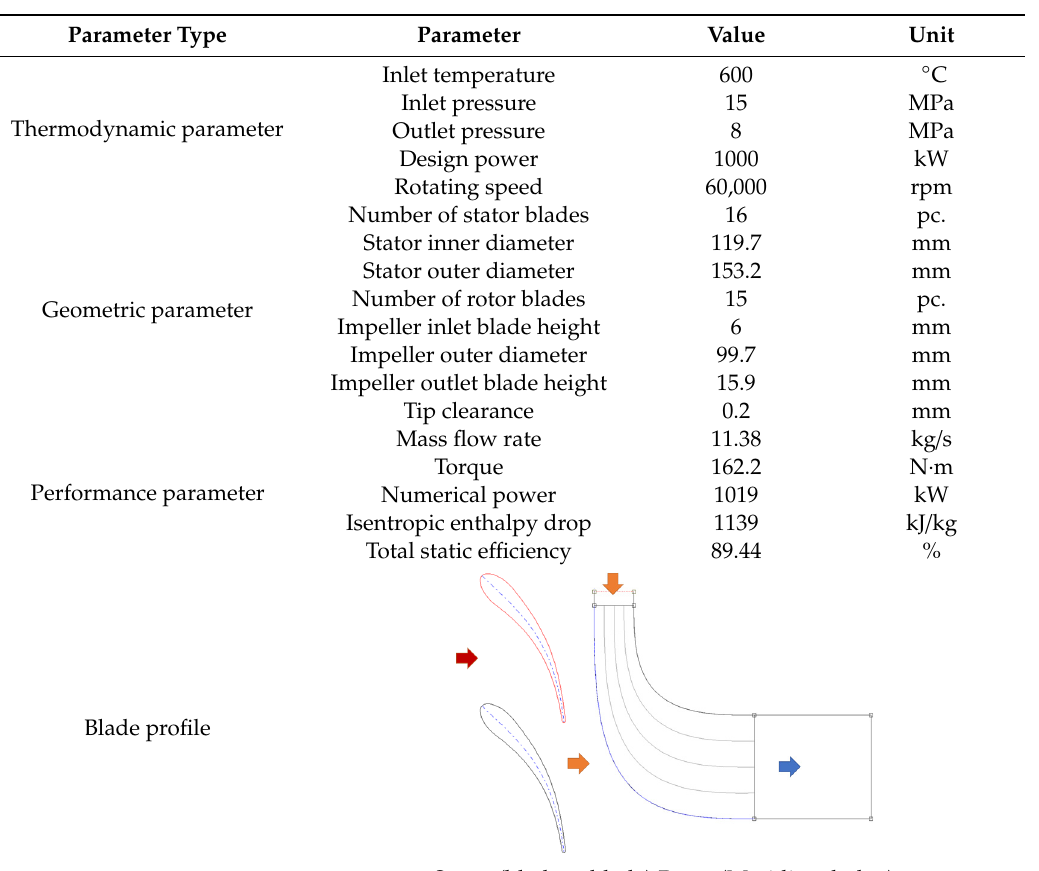
Table 2. Key design parameters.